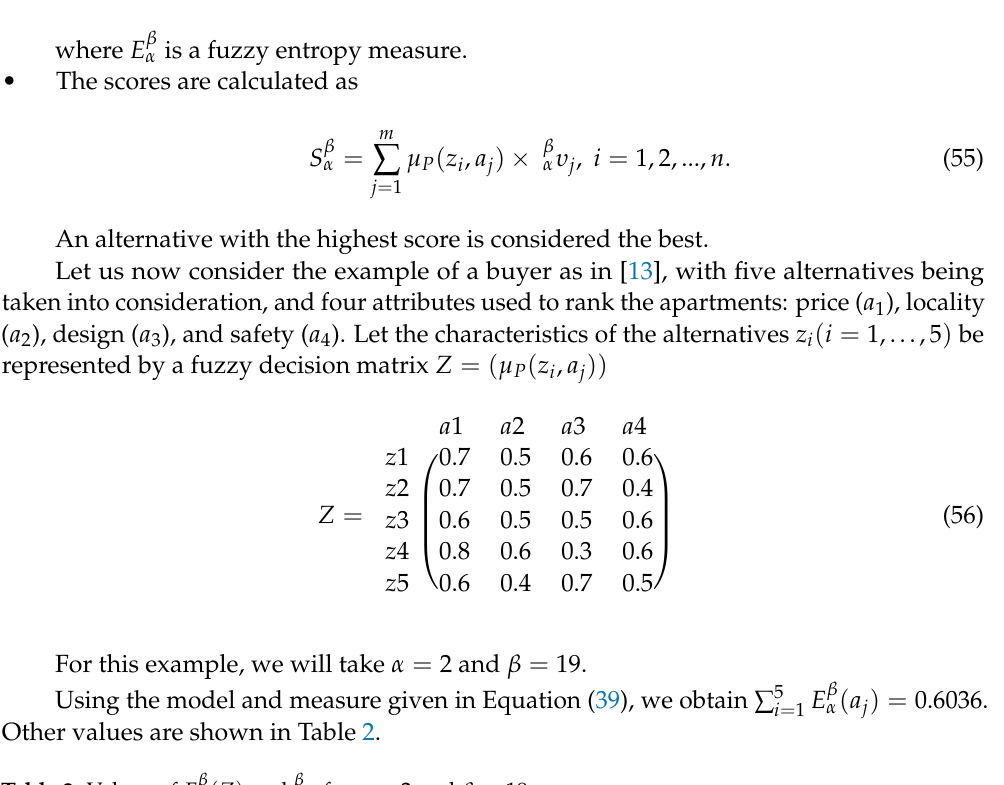
Table 2. Values of E β α ( Z ) and β α υ for α = 2 and β = 19. a 1 a 2 a 3 a 4 E β α 0.2323